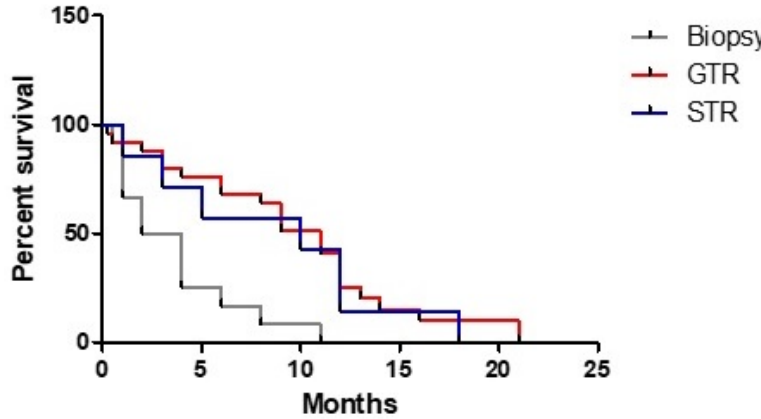
Figure 3. Correlation of extent of resection and overall survival.